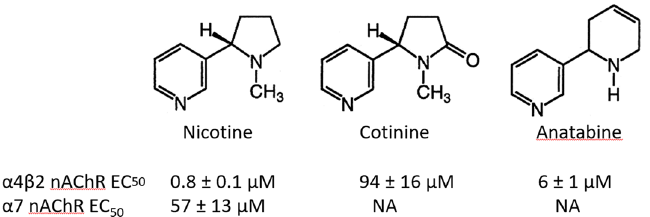
Figure 1. α4β2 and α7 nAChR EC 50 values of nicotine, cotinine, and anatabine. α4β2 and α7 nAChRs EC 50 values were determined in Chinese hamster ovarian (CHO) cells overexpressing the respective human nAChRs as reported by Alijevic et al. 18 . Nicotine and anatabine are potent, while cotinine is a weak α4β2 nAChR agonist. Nicotine is also a weak α7 agonist. NA not available due to no or low